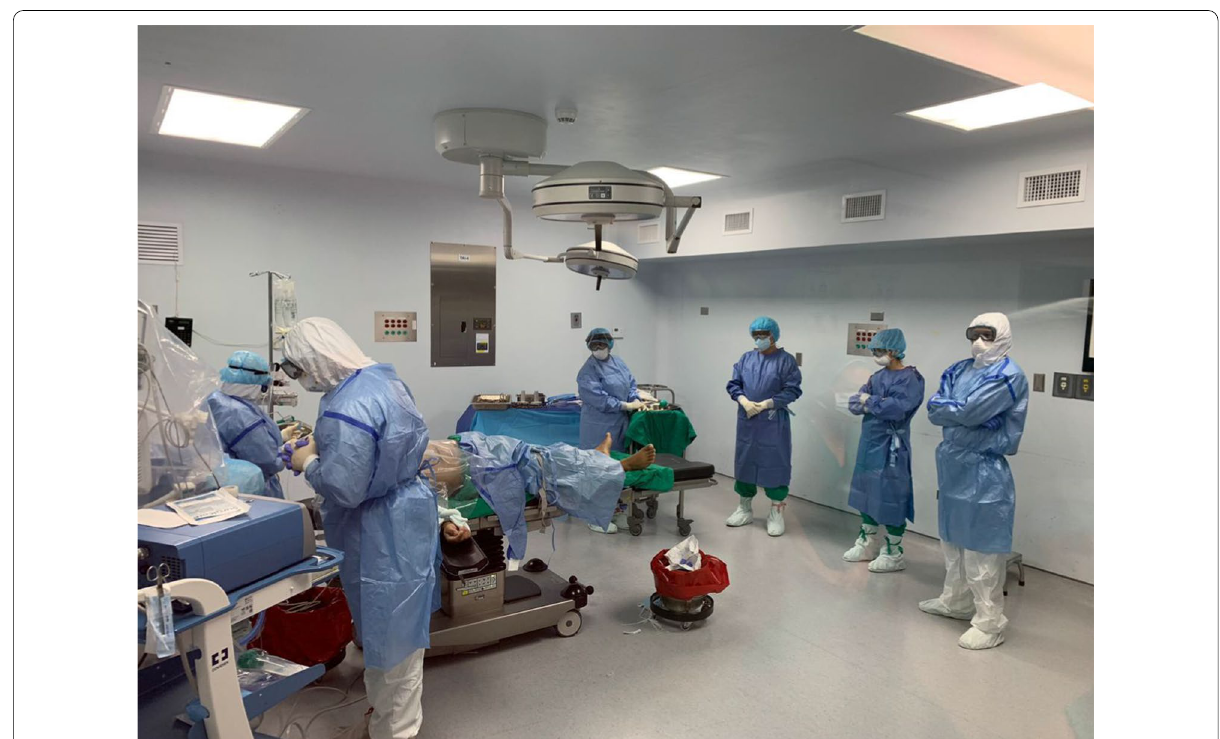
Fig. 3 COVID‑19 surgical team wearing the recommended PPE during the initial part of the